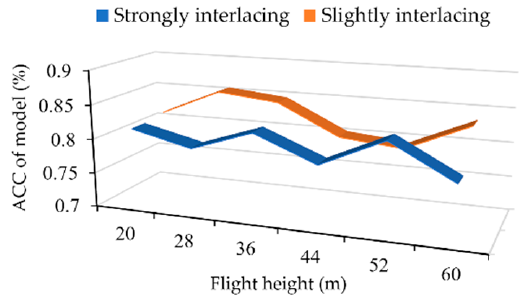
Figure 19. The relationship between altitude of image taken and accuracy (ACC) of the model at different intermingling degrees.